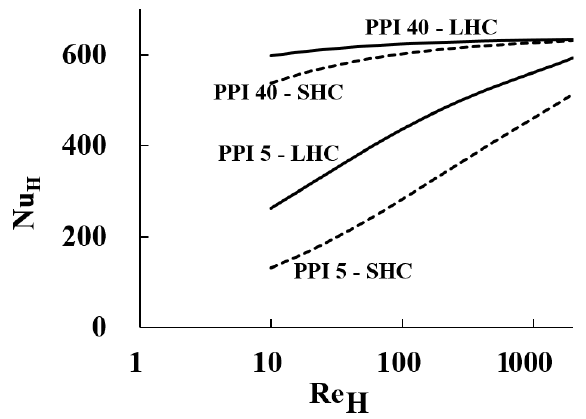
Figure 8. The change of 𝑁𝑢 𝐻 with channel Reynolds number for 5 and 40 PPI aluminum foams.